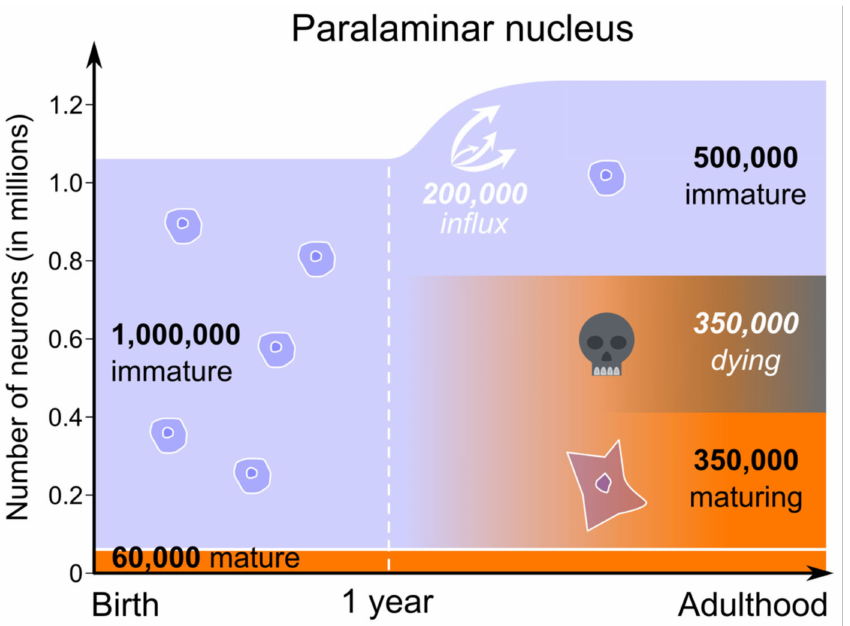
Figure 5. Proposed sequence of neuron maturation in the paralaminar nucleus of the monkey amygdala. Light blue: immature neuron population; orange: mature neuron population. Numbers in white italic are speculative (number of dying and migrating cells). The number of dying neurons is based on the hypothesis that ~50% of neurons die in the course of maturation (see main text). All other neuron number estimates were obtained with design-based stereological techniques applied to Nissl-stained brain sections of monkeys at different postnatal ages ( n = 27;